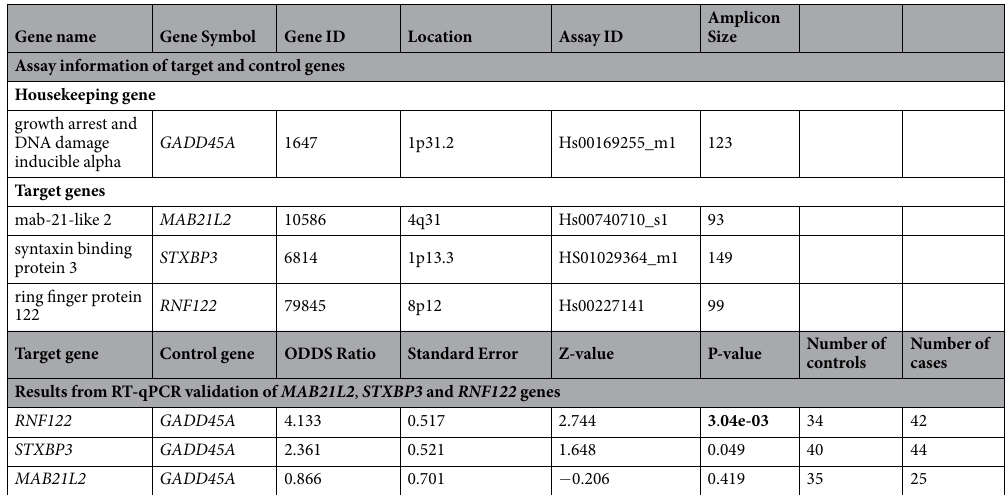
Table 6. Validation of MAB21L2 , STXBP3 and RNF122 gene expression differences between pharmacologically-naive ADHD subjects and healthy unrelated controls by RT-qPCR. Statistically significant P-values after applying a Bonferroni threshold of P-value < 0.017, when taking into account three genes (0.05/3), are shown in